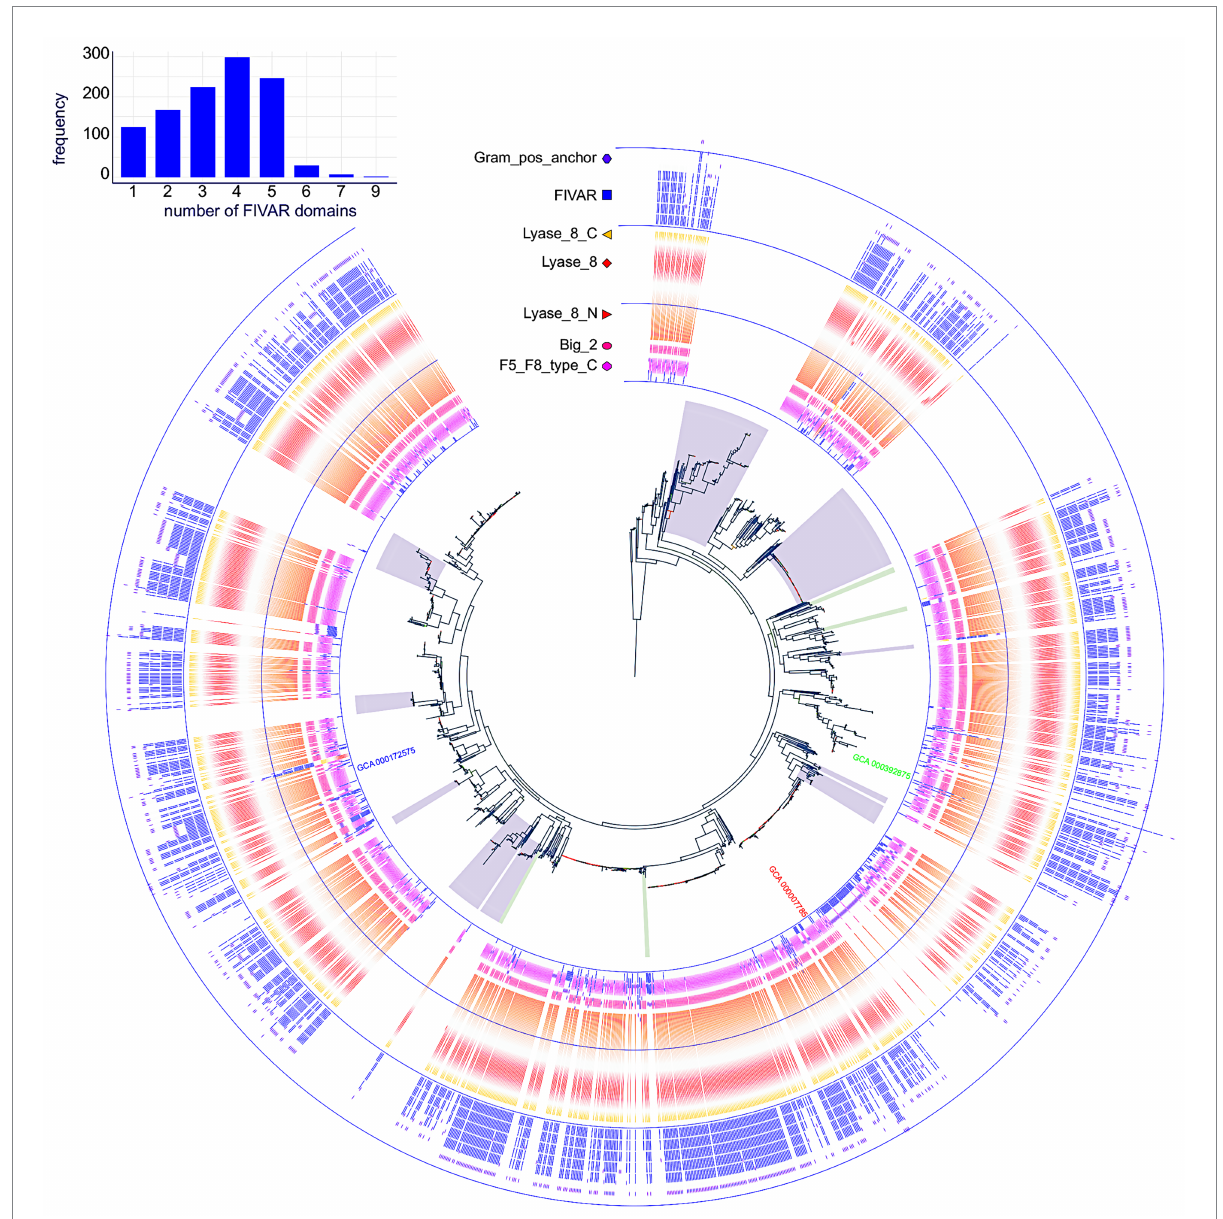
FIGURE 7 Distribution of HylA protein in Enterococcus faecalis genomes. The tree of the 1949 E . faecalis strains was inferred with IQ-TREE from the concatenated alignments of the orthologous gene clusters identified by Panaroo . Branch support, indicated by a color gradient (red to blue), was estimated with the SH approximate likelihood ratio test. The tree was rooted by adding the genomes of E . caccae and E . rivorum , which are the closest species to E . faecalis on the Enterococcaceae species tree. The location of strains V583 (GCA_000007785), OG1RF (GCA_000172575), and ATCC 19433 (GCA_000392875) on the tree are highlighted. The ring shows the organization of the Pfam domains of the proteins, with the same color code as in Figure 6. The absence of domains indicates the absence of the hylA gene in the strain. Subtrees where the hylA gene is absent are highlighted. The distribution of the number of FIVAR domains is plotted in the upper left